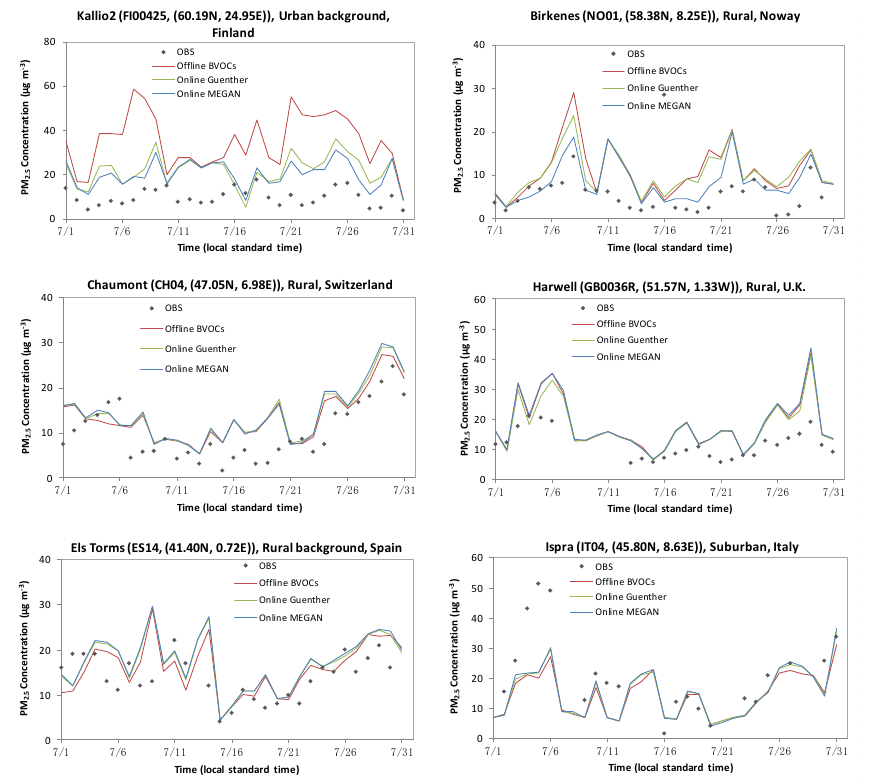
Fig. 13. Simulated and observed concentrations of 24h average PM 2 . 5 over D01 from WRF/Chem-MADRID using offline BVOC emissions Figure 13. Simulated and observed concentrations of 24-hr average PM 2.5 over D01 from of Simpson et al. (1999) and online BVOC emission modules based on modified Guenther (Guenther et al., 1995) and MEGAN (Guenther WRF/Chem-MADRID using offline BVOCs emissions of Simpson et al. (1999) and online BVOCs emission modules based on modified Guenther (Guenther et al., 1995) and et al., 2006) in July 2001 at selected sites over MEGAN (Guenther et al., 2006) in July 2001 at selected sites over D01.